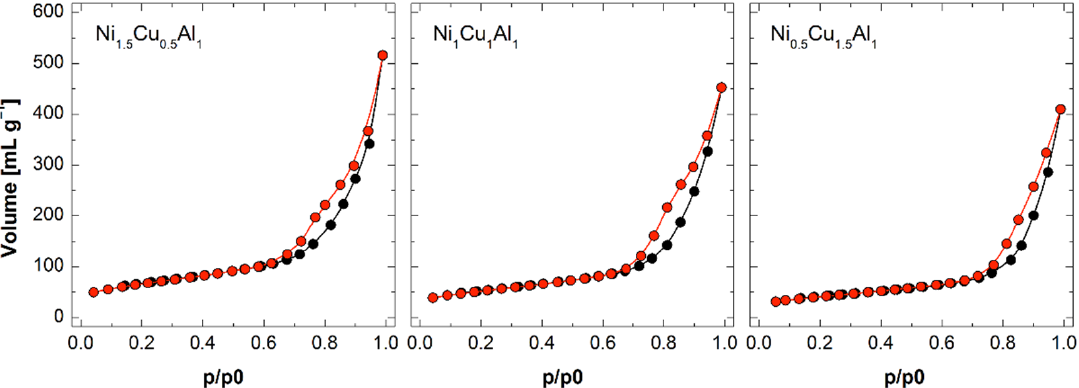
Figure 1. N 2 physisorption isotherms of LDH precursors calcined at 673 K for 4 h. Black line is the adsorption branch and the red line is the desorption branch of the isotherm.